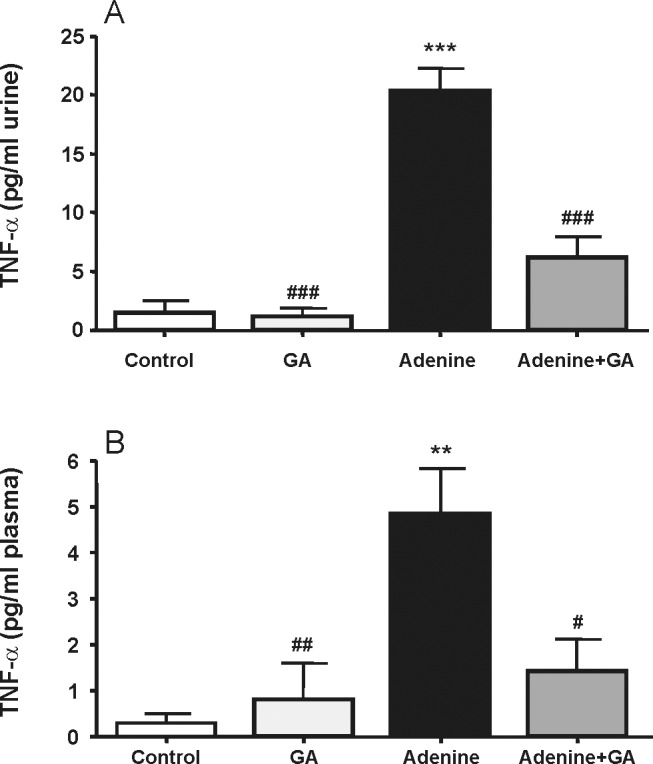
Tumor necrosis factor-α concentration in urine (A) and plasma (B) in control rats, rats treated with gum arabic (15% w/v in drinking water) and rats treated with adenine (0.75% w/w) alone in feed, or with adenine and gum arabic given concomitantly at the same dose for 28 days.Each column and vertical bar represents the mean ± SEM (n = 6). ** p<0.01, *** p<0.001 vs. control, # p<0.05, ## p<0.01,### p<0.001 vs. adenine treatment.